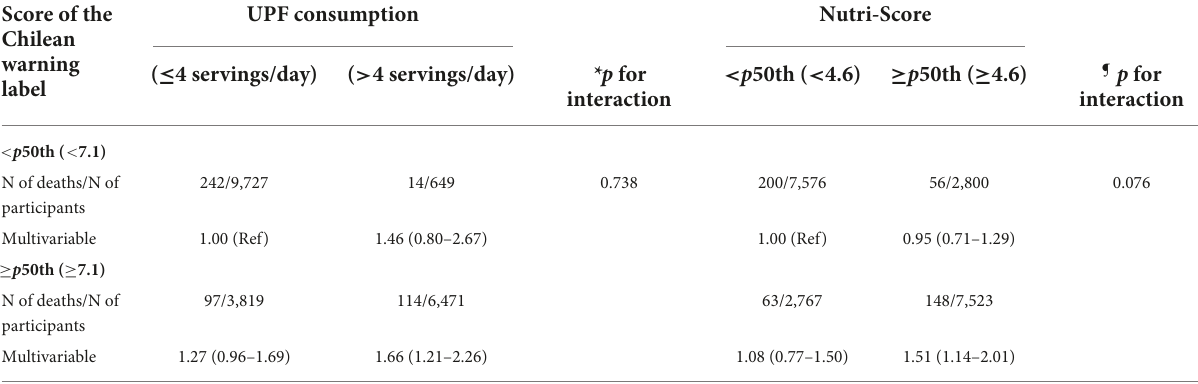
TABLE 3 Hazard ratios (95% confidence intervals) for all-cause mortality according to baseline median consumption of foods with Chilean warning labels, ultra-processed food (UPF), and